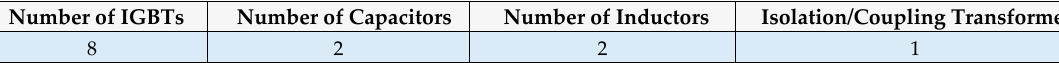
Figure 11. Hybrid co-phase RPC system (co-HRPC) (based on [20]). Table 9. Components quantities of the co-HRPC.